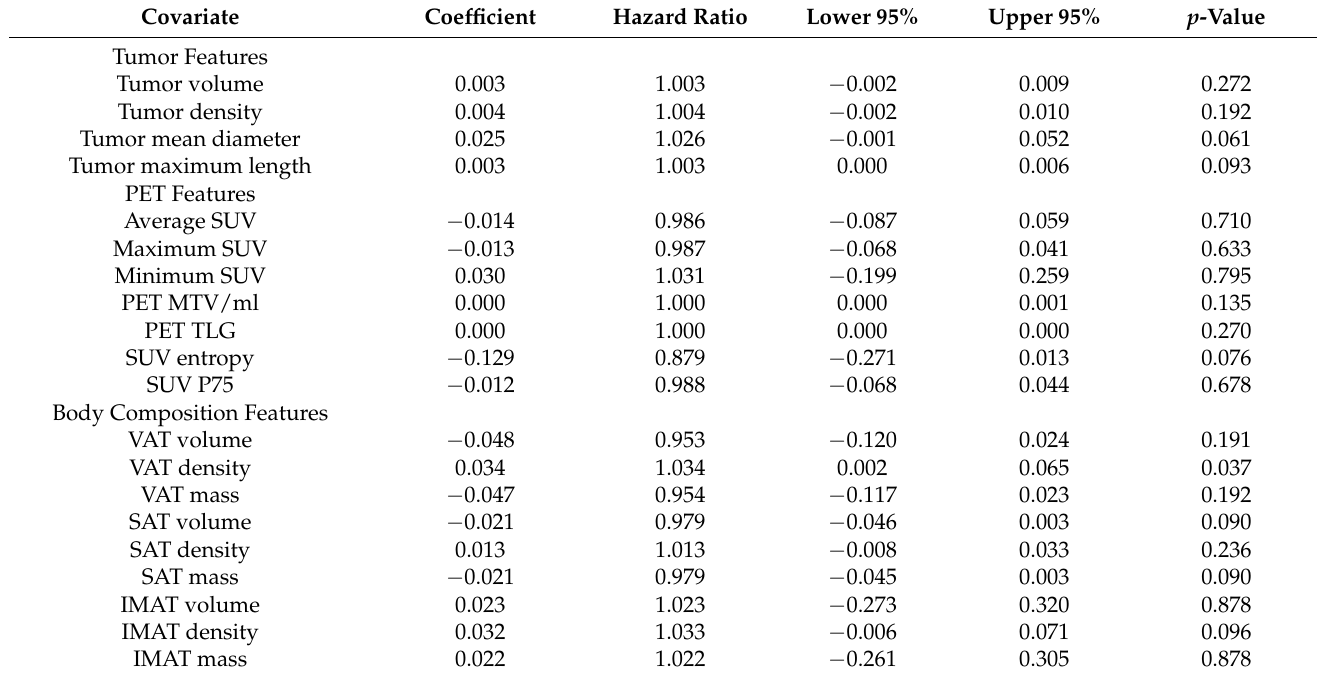
Table 3. Univariate Cox proportional-hazard models for image